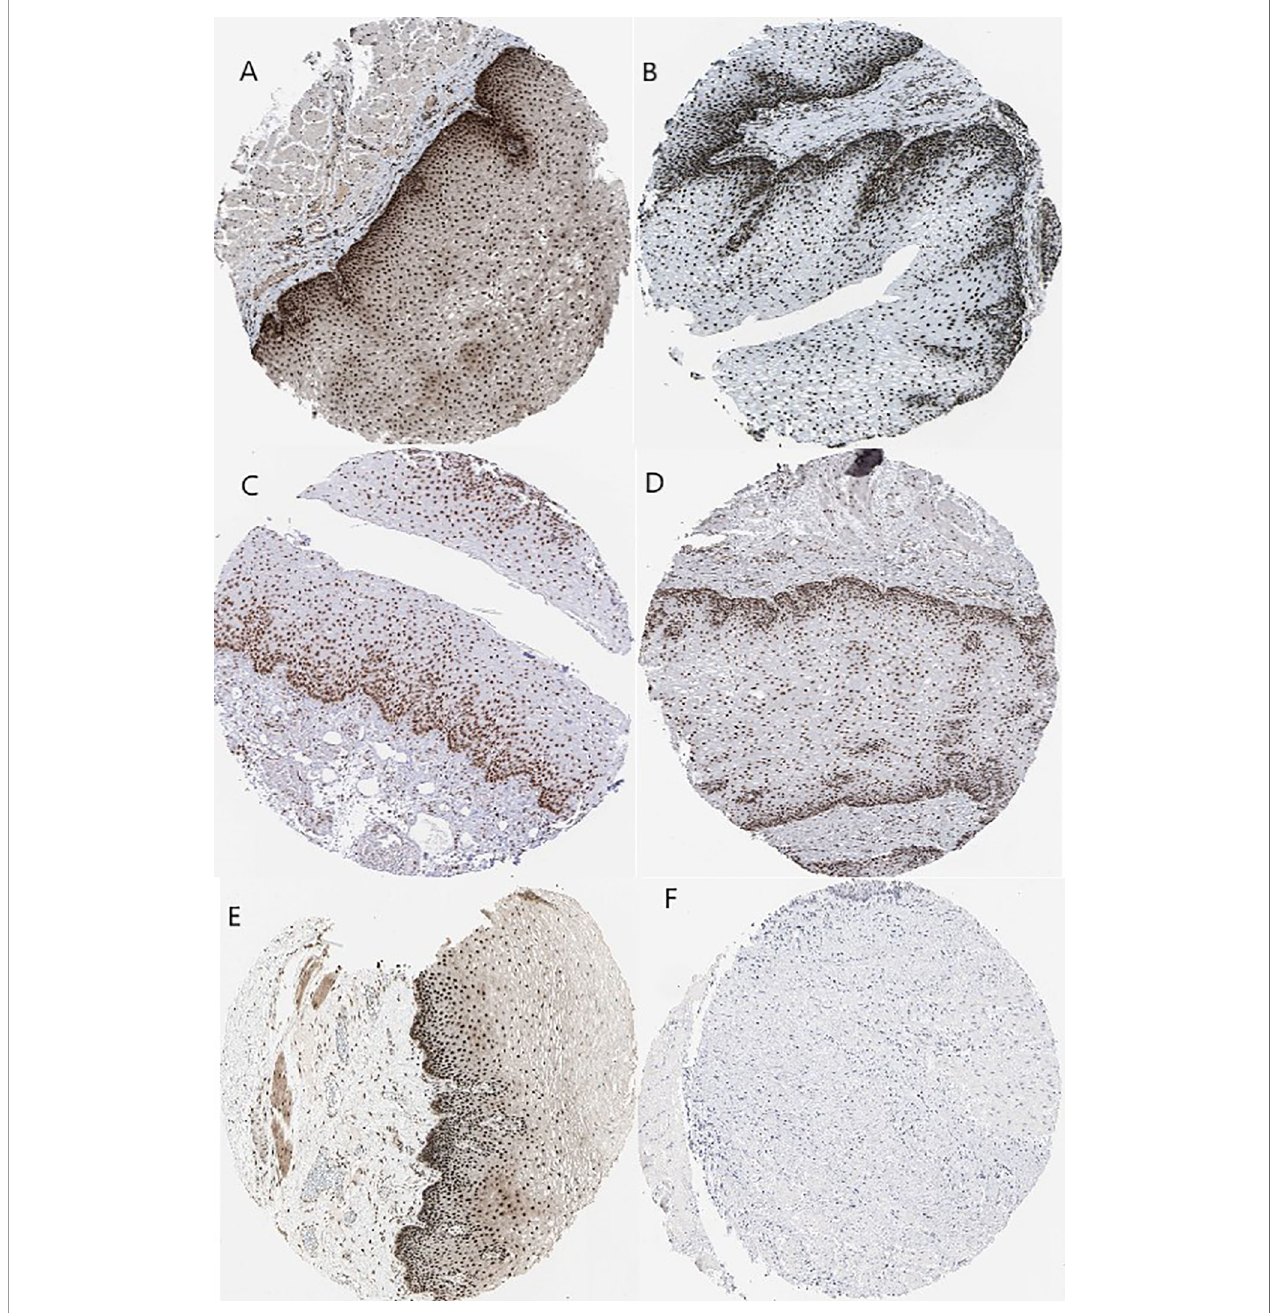
FIGURE 7 | Immunohistochemistry of the fi ve hub genes based on the Human Protein Atlas. (A) Protein levels of PRPF4 in normal tissue (staining: high; intensity: strong; quantity: >75%). (B) Protein levels of SRSF1 in normal tissue (staining: high; intensity: strong; quantity: >75%). (C) Protein levels of SRSF1 in tumor tissue (staining: high; intensity: strong; quantity: >75%). (D) Protein levels of HNRNPM in normal tissue (staining: high; intensity: strong; quantity: >75%). (E) Protein levels of DHX9 in normal tissue (staining: high; intensity: strong; quantity: >75%). (F) Protein levels of ORC2 in normal tissue (staining: not detected; intensity: low; quantity: